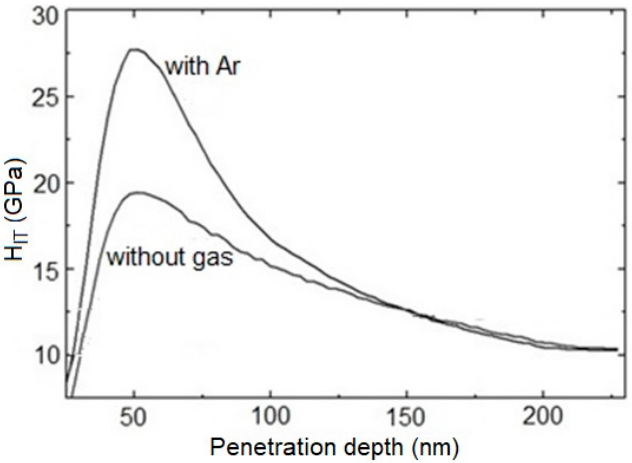
Figure 3. Depth profiles of the H IT of WC/C coatings.